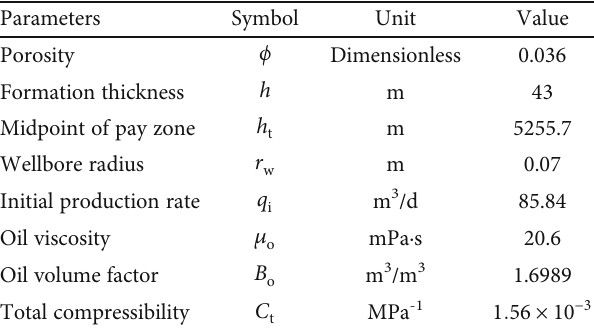
Table 4: Basic input parameters for validation case